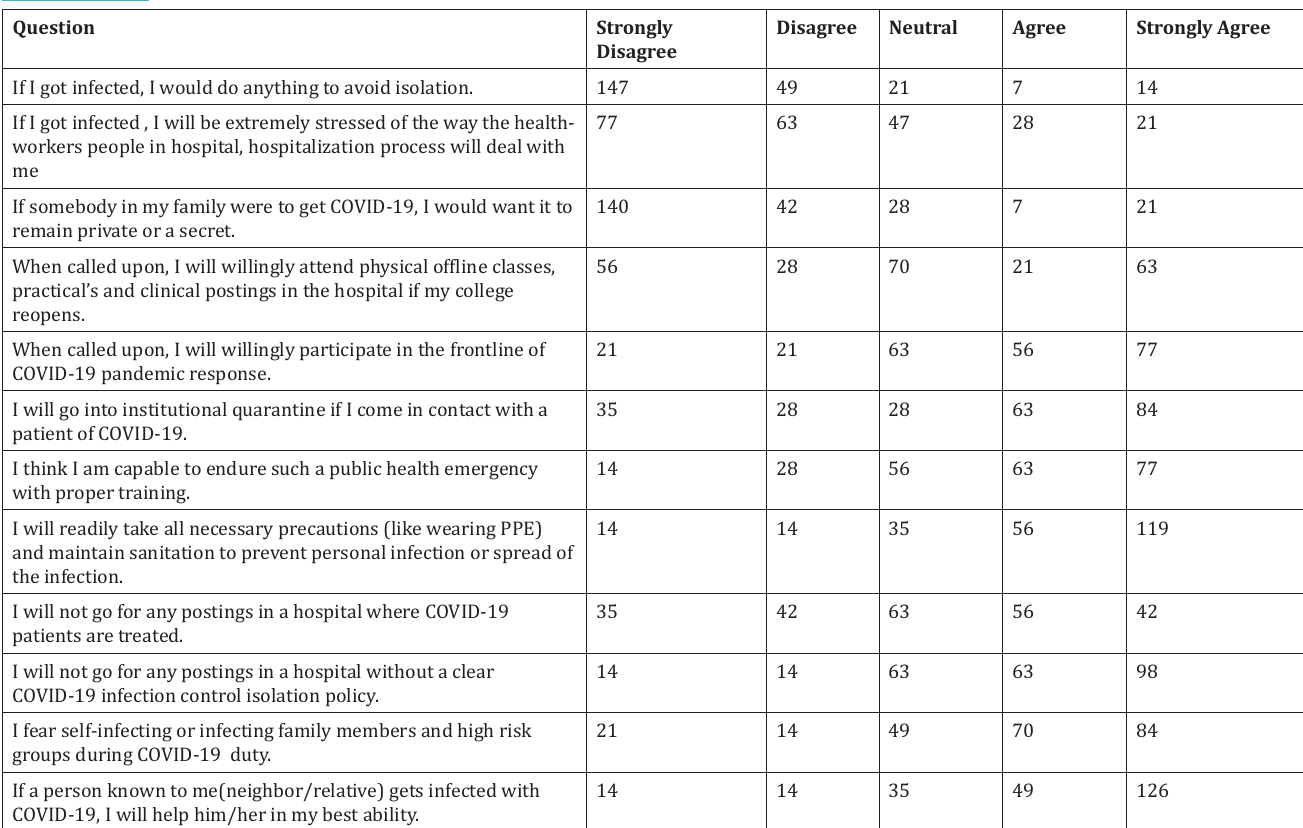
Table 4 Response to Attitude aspect for Covid-19 infection with once choice option